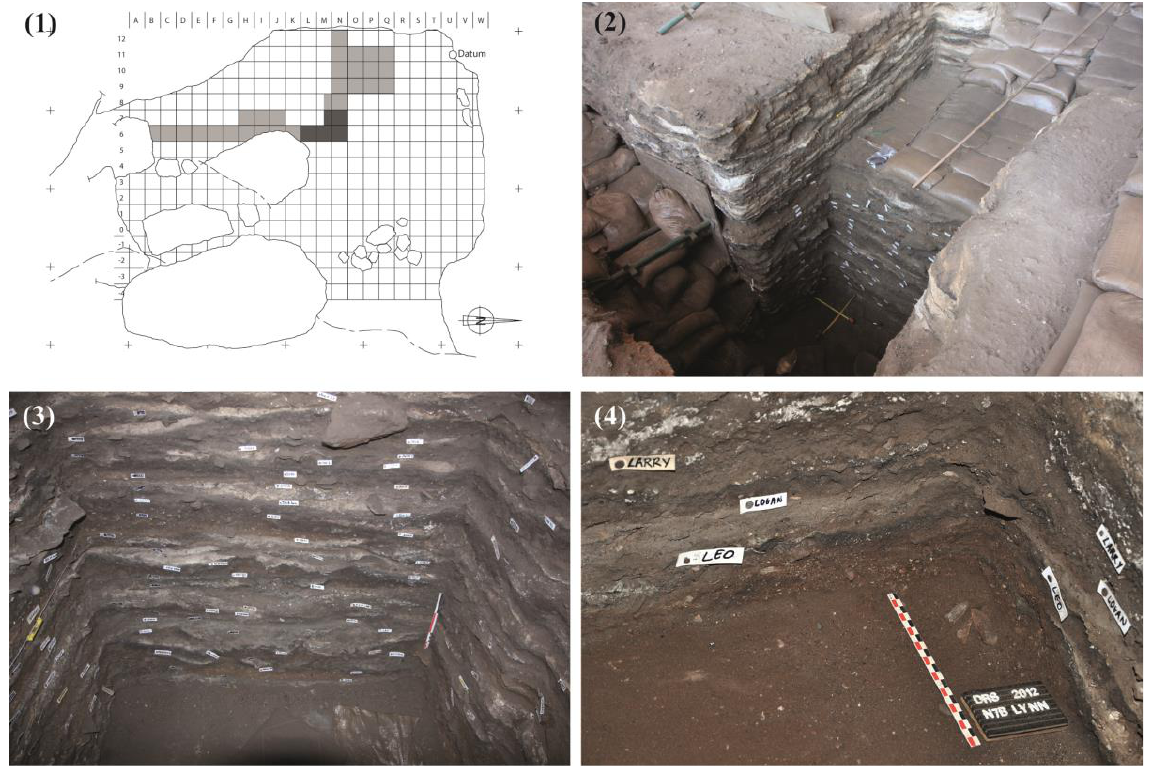
Figure 2 . (1) Planimetry of Diepkloof Rock Shelter (in dark grey: squares where the stratigraphic unit Lynn has been excavated) and various photographs of the 2012-2013 excavations with detail (2) on the excavated area, (3) on the M-N7/M-N8 stratigraphic profile and (4) on the engraved bone at the time of its discovery in the stratigraphic unit Lynn. A high resolution version of this figure is available at